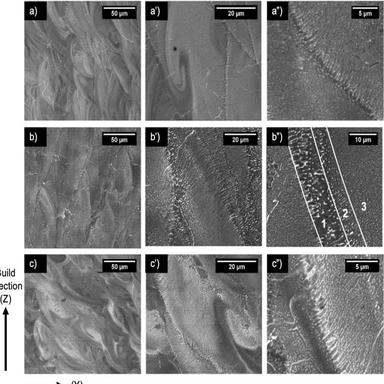
Backscattered electron SEM micrographs of LPBF prepared Al-Zn-Mg at several magnifications. (a, a' and a") Al-10Zn-2Mg; (b, b' and b") Al-14Zn-3Mg; (c, c' and c") Al\\18Zn\\4Mg. The low magnification of the alloys (a, b and c) show melt-pool tracks that are developed during the LPBF process. The higher magnification (a", b" and c") images reveal the presence of spherical and plate-like particles with fine cellular and coarse dendritic structures.